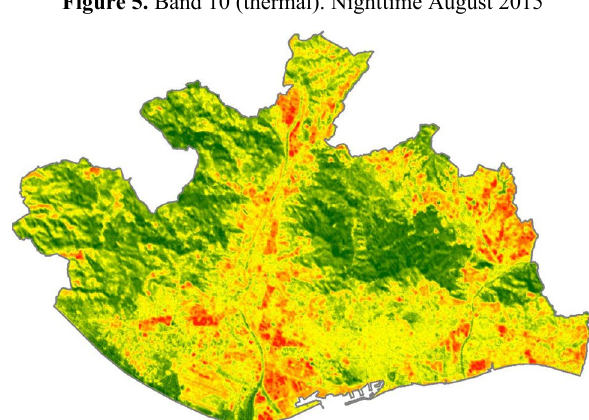
Figure 5. Band 10 (thermal). Nighttime August 2015